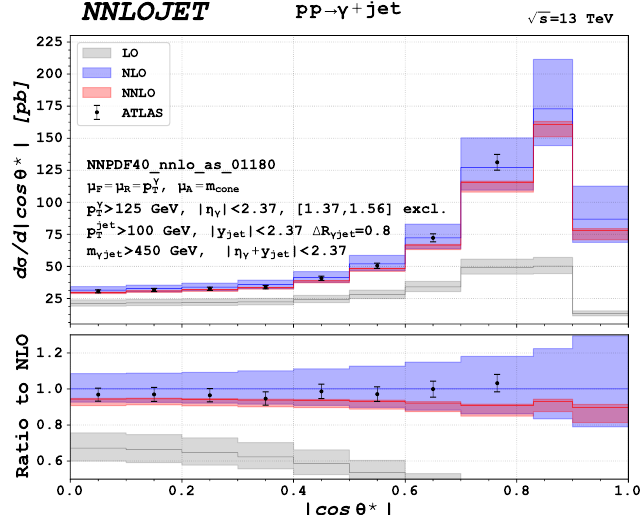
Figure 8. Predictions for the photon-plus-jet cross section differential in | cos θ ∗ | at LO, NLO, and NNLO. The predictions are compared to data from the ATLAS measurement